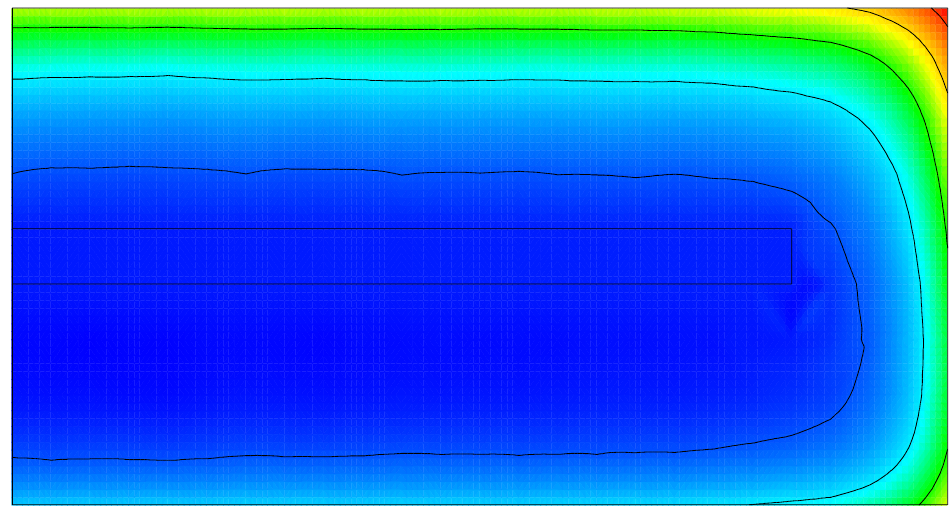
Figure 5. Contours of the potential around the metal rail.